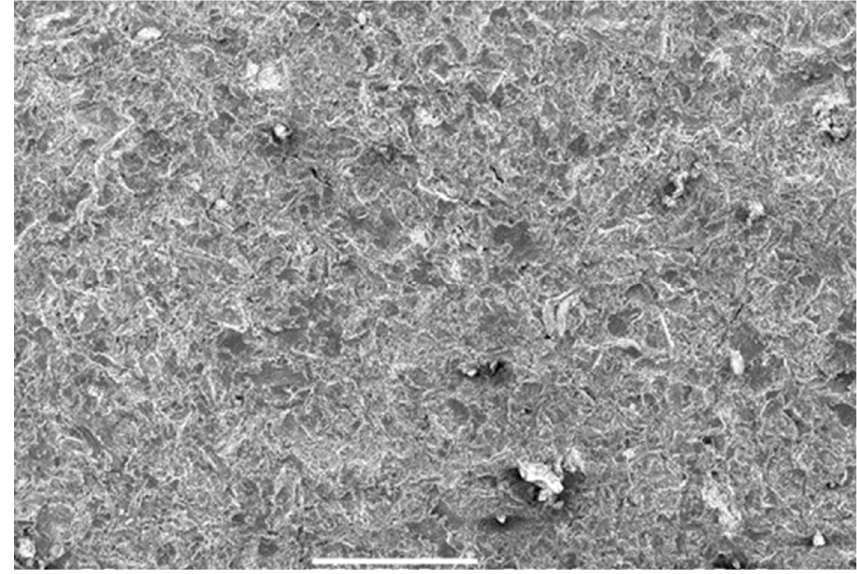
Figure 5. SEM picture after blasting an unalloyed steel (S355) with corundum of average grain size F022 (710–1000 µm). Scale bar = 500 µm. (TU Braunschweig).